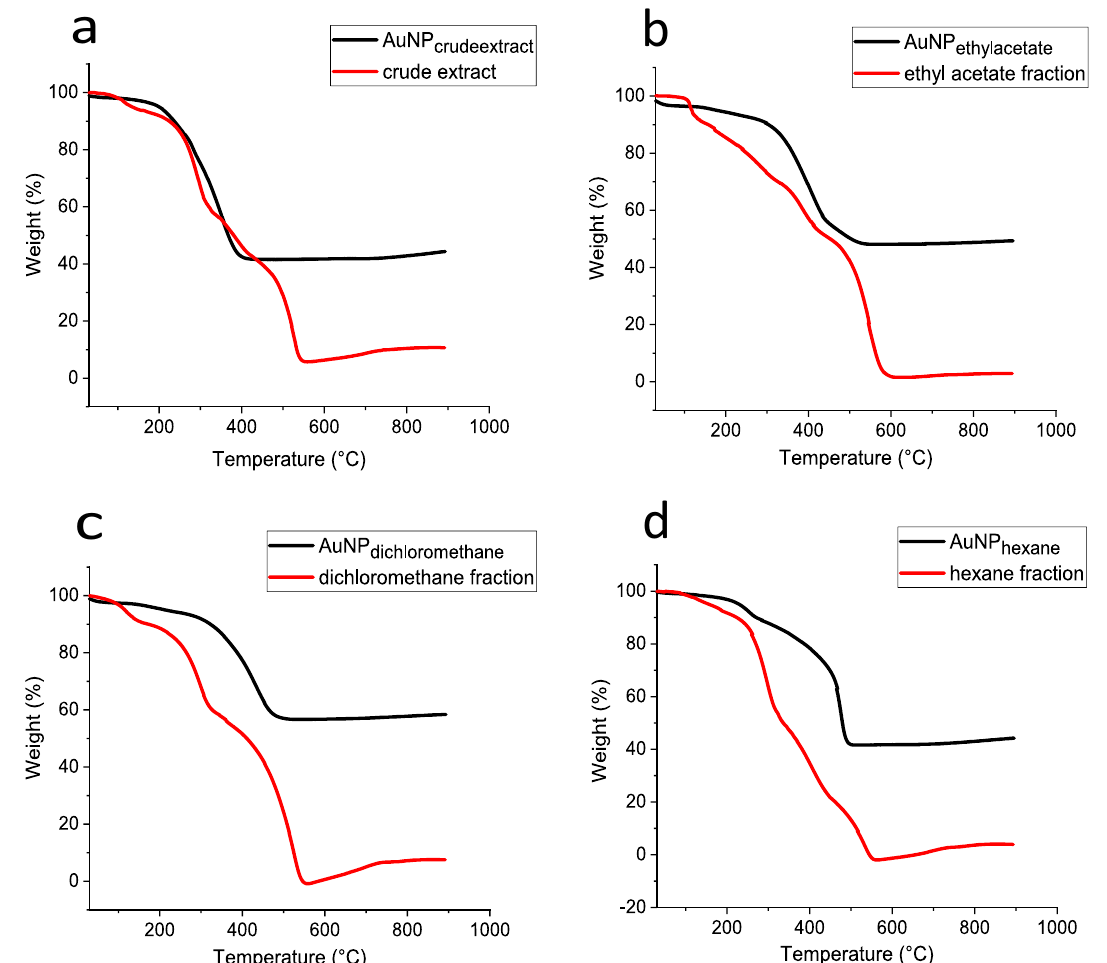
Figure 7. TGA analysis of BRP crude extract and its fractions as well as the biosynthesized AuNPs.